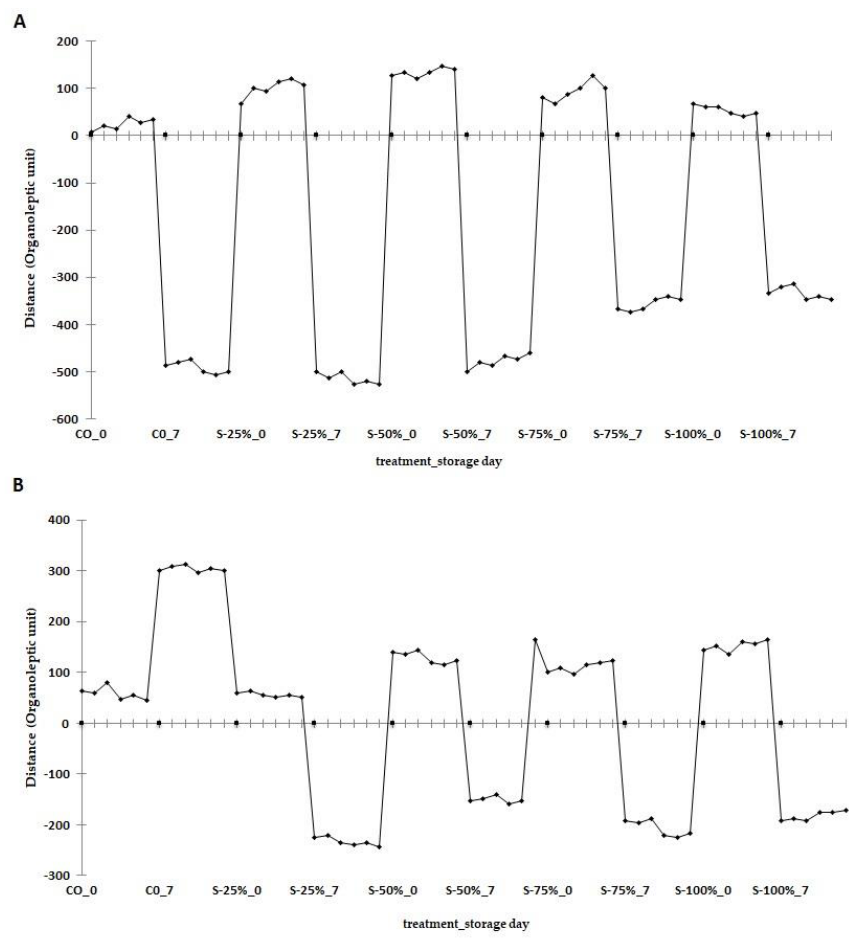
Figure 4. Changes in the volatile compounds profile of raw burgers ( A ); grilled burgers ( B ); after 0, 7 days of storage (4 ± 1 °C); CO-control with tallow (0% fat substitute), S-25%, S-50%, S-75%, S-100% means respectively replacing beef fat with 25, 50, 75, and 100% substitute.